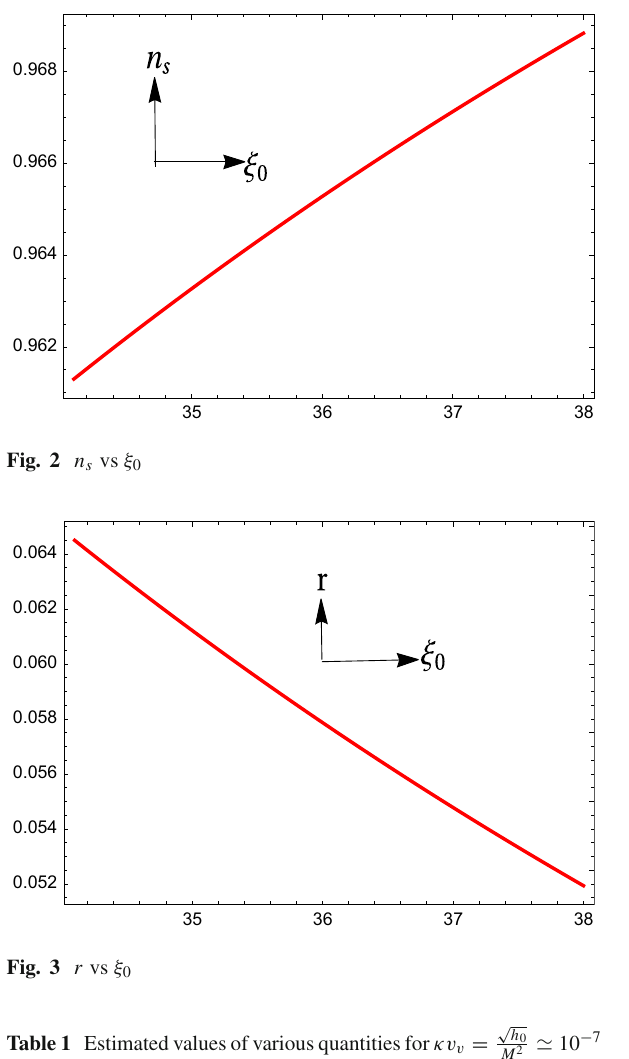
Fig. 4 T ( t ) (cid:5)